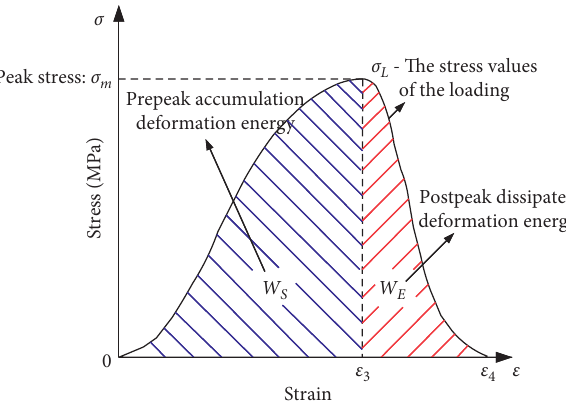
Figure 13: Legend of Impact Energy Index calculation.